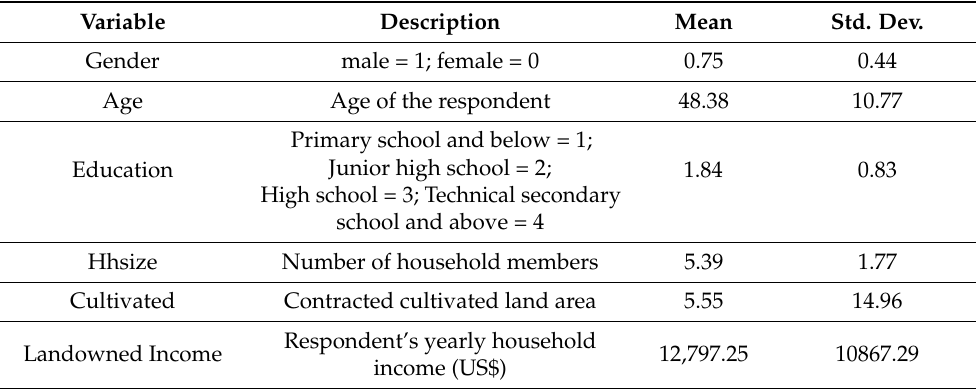
Table 2. Descriptive statistics of the survey sample.